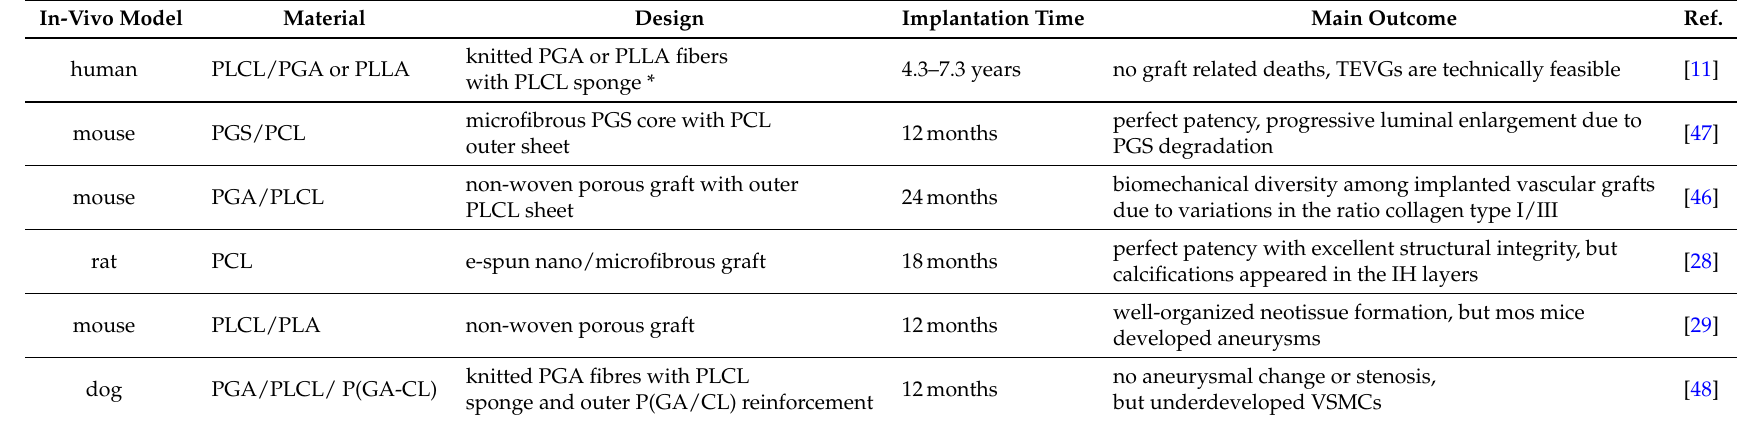
Table 2. Selection of in vivo studies applying the in situ TE approach, with a specific focus on long-term